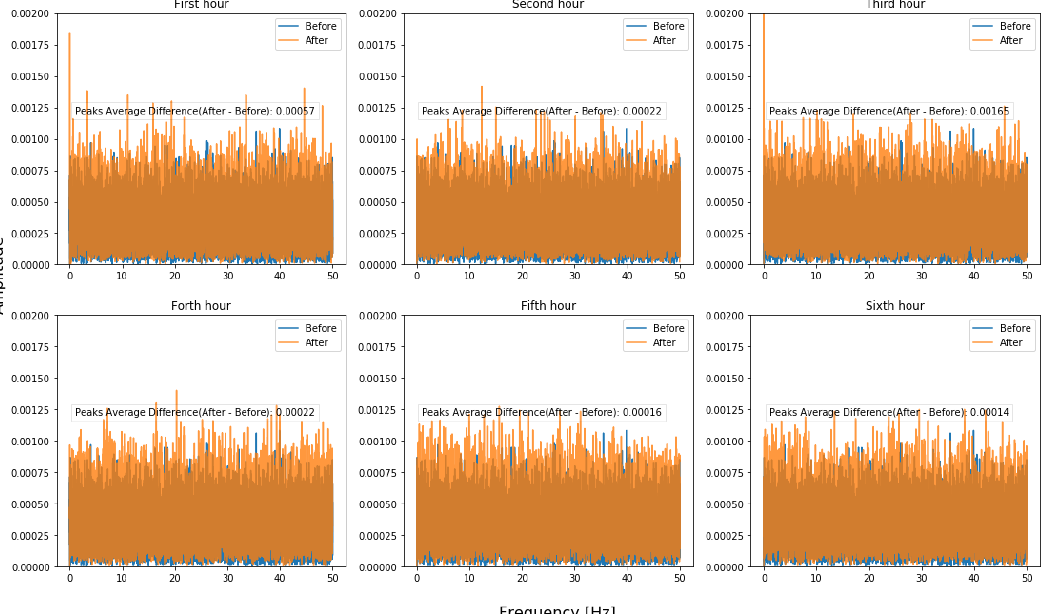
Figure 11. FFT Frequency domain plot for data collected from outside sensor before and after inserting Red Palm Weevils through hours.